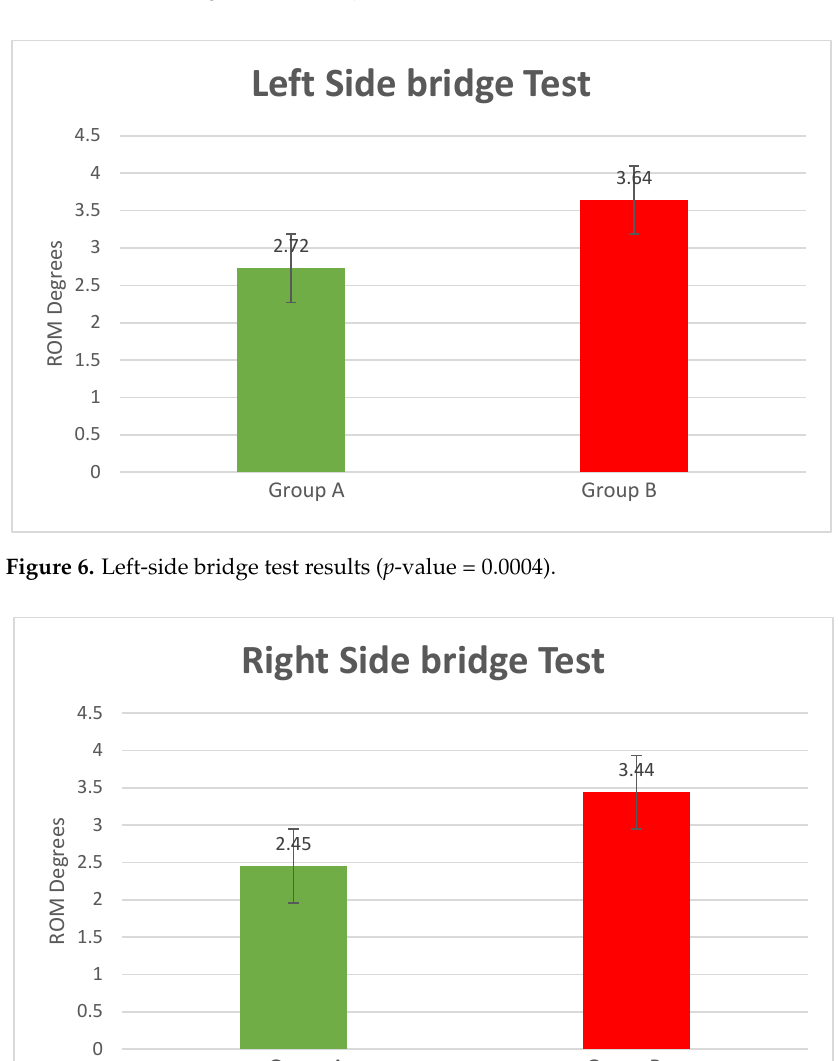
Figure 7. Right-side bridge test results ( p -value = 0.00002). We present some indicative diagrams for the lumbar spine kinematics behavior for both groups in the three tests, as shown in Figures 8 – 10.